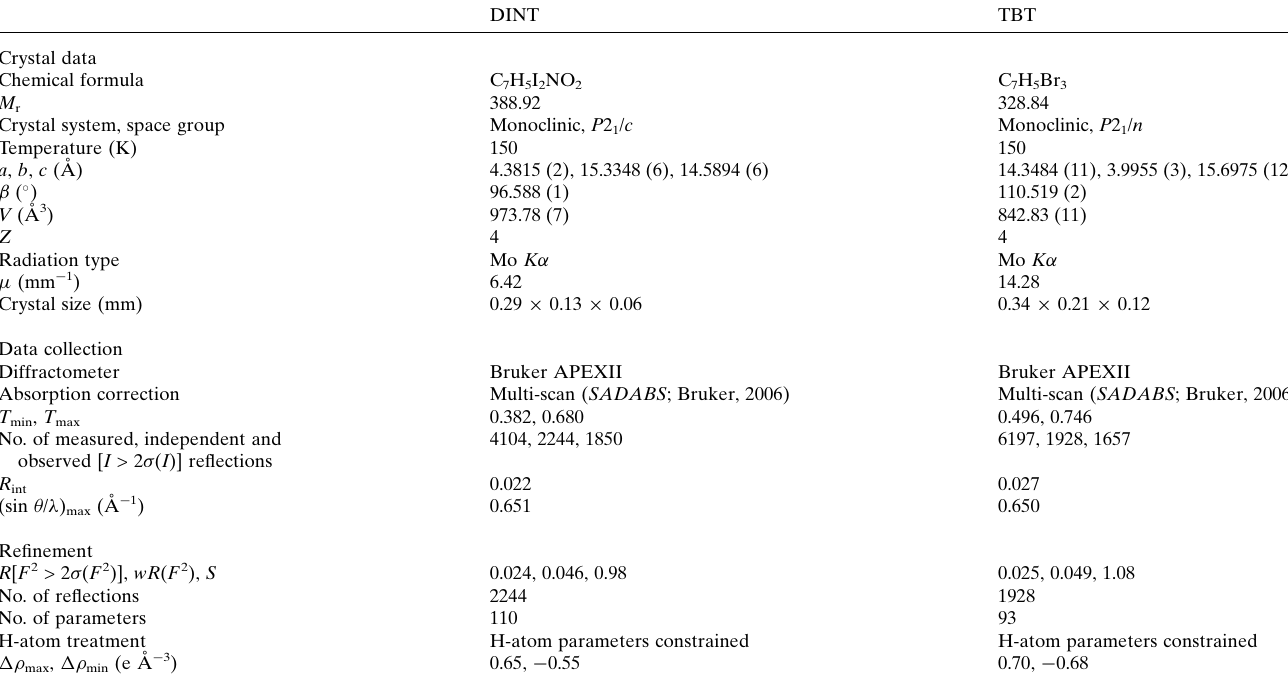
Crystal data Chemical